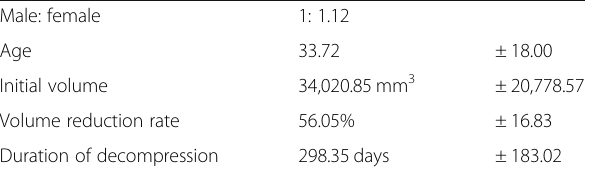
Table 1 Demographic of patients ’ information